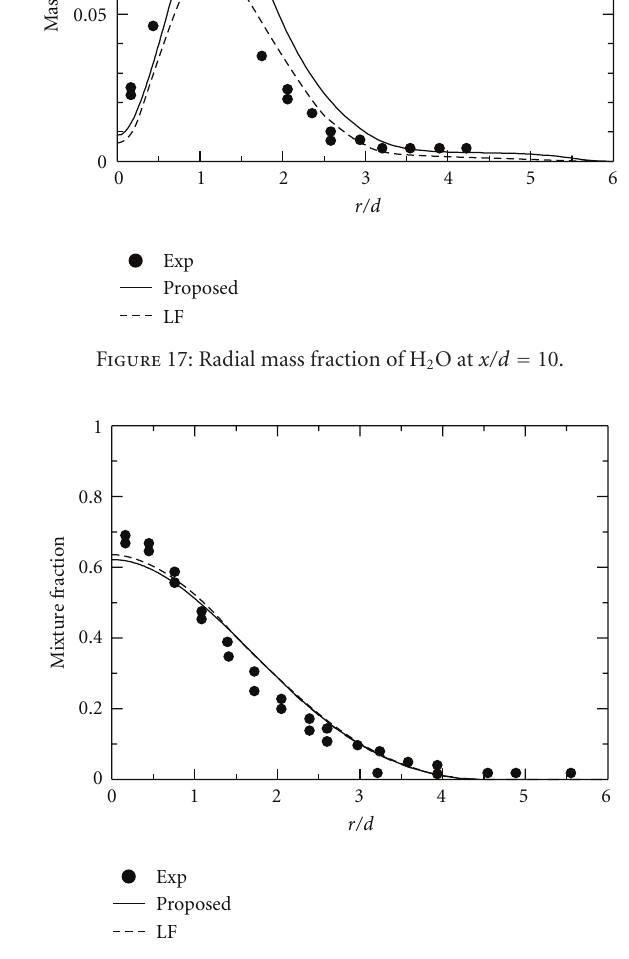
Figure 18: Radial mixture fraction at x/d =